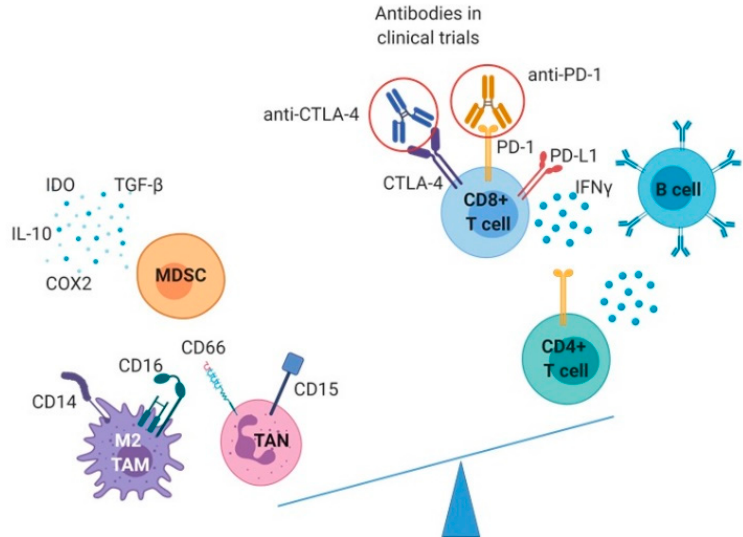
Figure 2. Immunological characterization and immunotherapeutic strategies in CCA. Schematic representation of the innate immune cells promoting tumor growth (left part of the balance) in comparison with the adaptive immune cells implicated in the tumor growth control. Abbreviations: